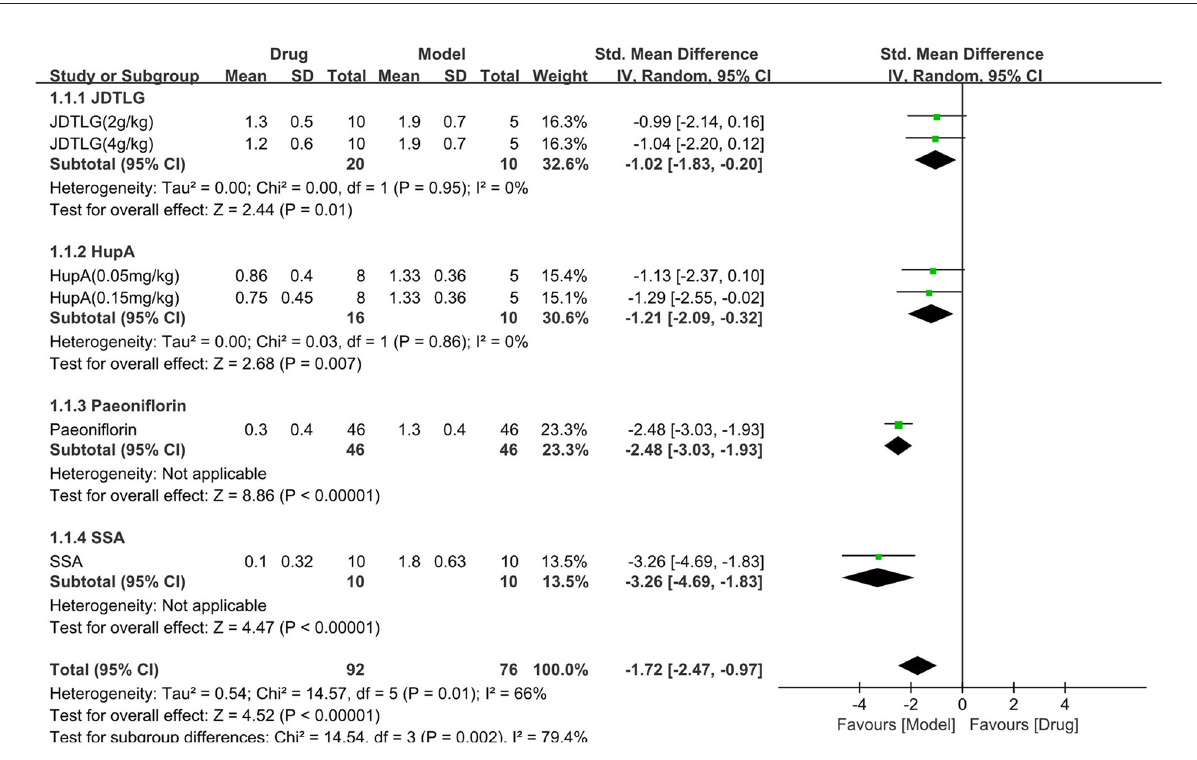
FIGURE7 Efficacy of CHM on neurological deficit score. Forest plots of the effect size calculated using SMDs. The horizontal error bars represent the 95% confidence interval of individual studies.